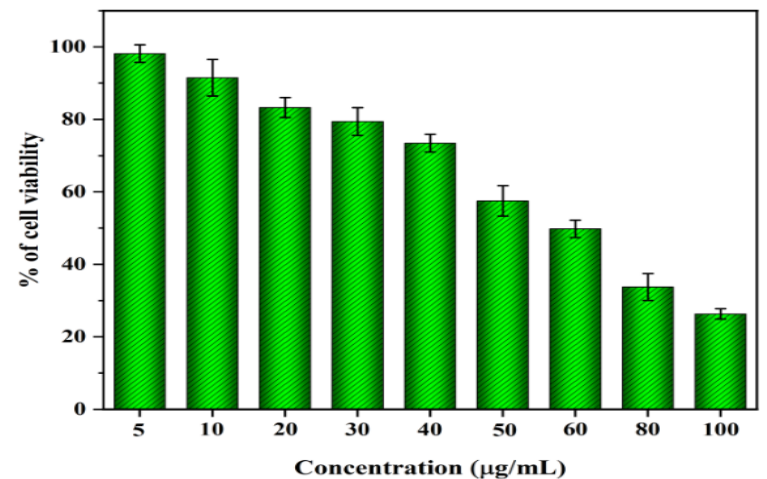
Figure 9. Cytotoxicity of fucoidan from S. illicifolium on HepG2 cells.